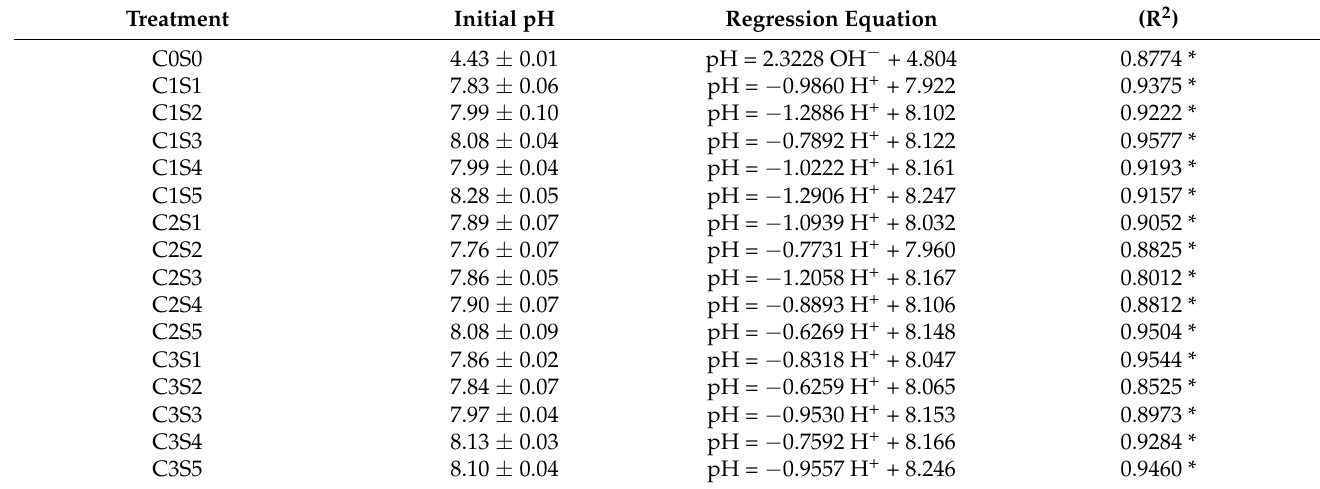
Table 7. Initial soil pH, regression equations for the relationships between the amount of hydrogen or hydroxide ions added to the soil and pH change, and the regression coefficient (R 2 ) for the different treatments after thirty days of leaching.